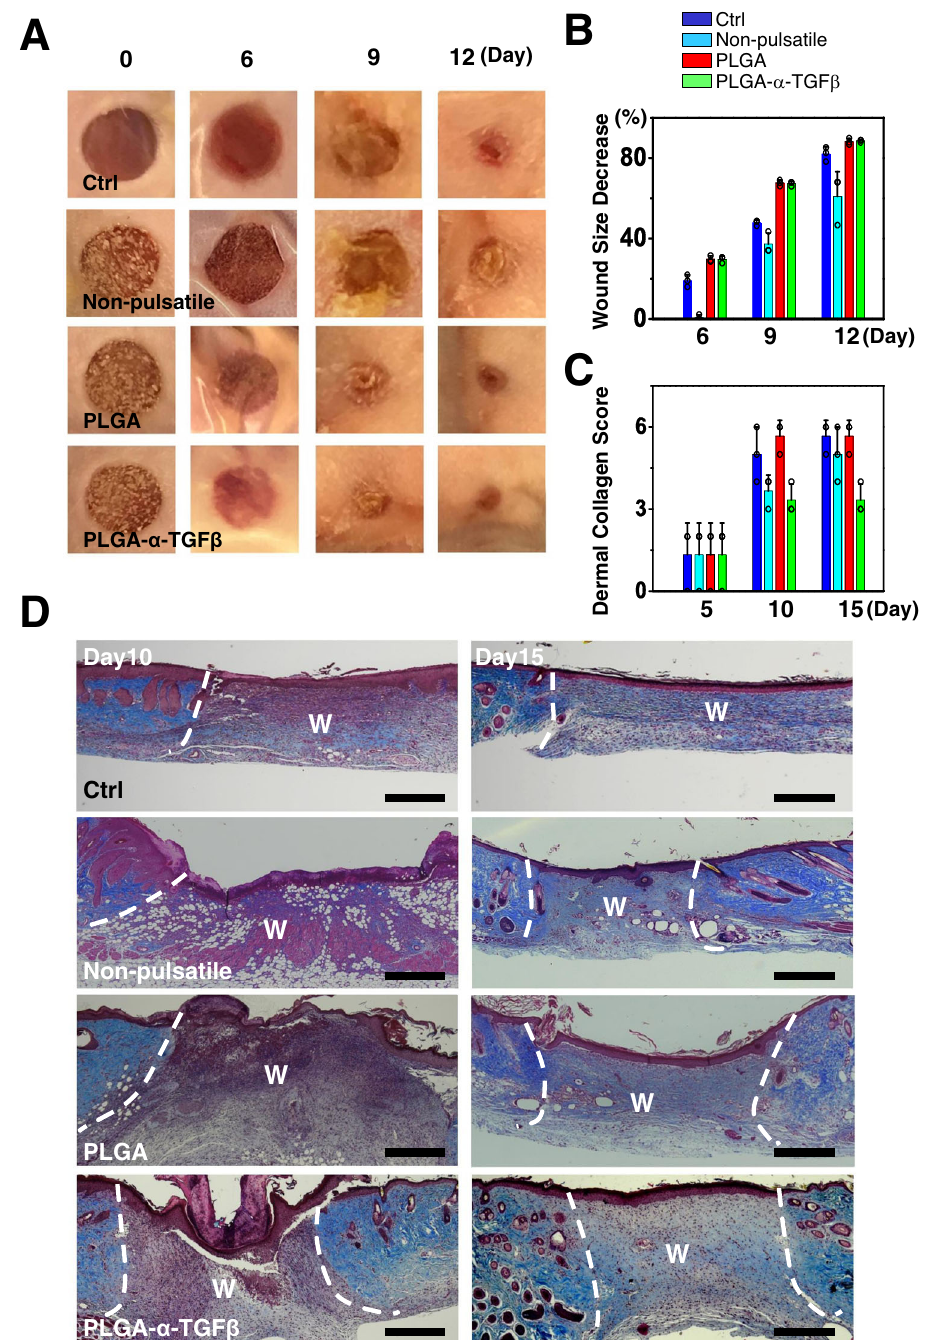
Fig. 4 Delivery of TGF β inhibitor with PLGA-NB capsules can enhance skin wound closure while suppressing scarring. A , B Representative wound images ( A ) and quanti fi cation of wound size ( B ) show that application of PLGA capsules with or without TGF β inhibitor in HA-NB hydrogel can accelerate wound closure in murine skin with full thickness skin wounds. Delivery of TGF β inhibitor in non-pulsatile release HA hydrogel inhibits wound healing. Treatment with alginate hydrogel was used as control (Ctrl). n = 3 independent samples. Data are presented as mean±SD. C Quanti fi cation of collagen deposition and tissue fi brosis at different time points after wounding (Materials and Methods). n = 3 independent samples. Data are presented as mean±SD. All error bars represent SD. D Trichrome staining of skin sections treated with PLGA capsules or PLGA capsules loaded with TGF β inhibitor or control hydrogel at different time points post wounding. Dashed lines denote wound (W) boundary. scale bar = 500 μ m. Source data are provided as a Source Data fi